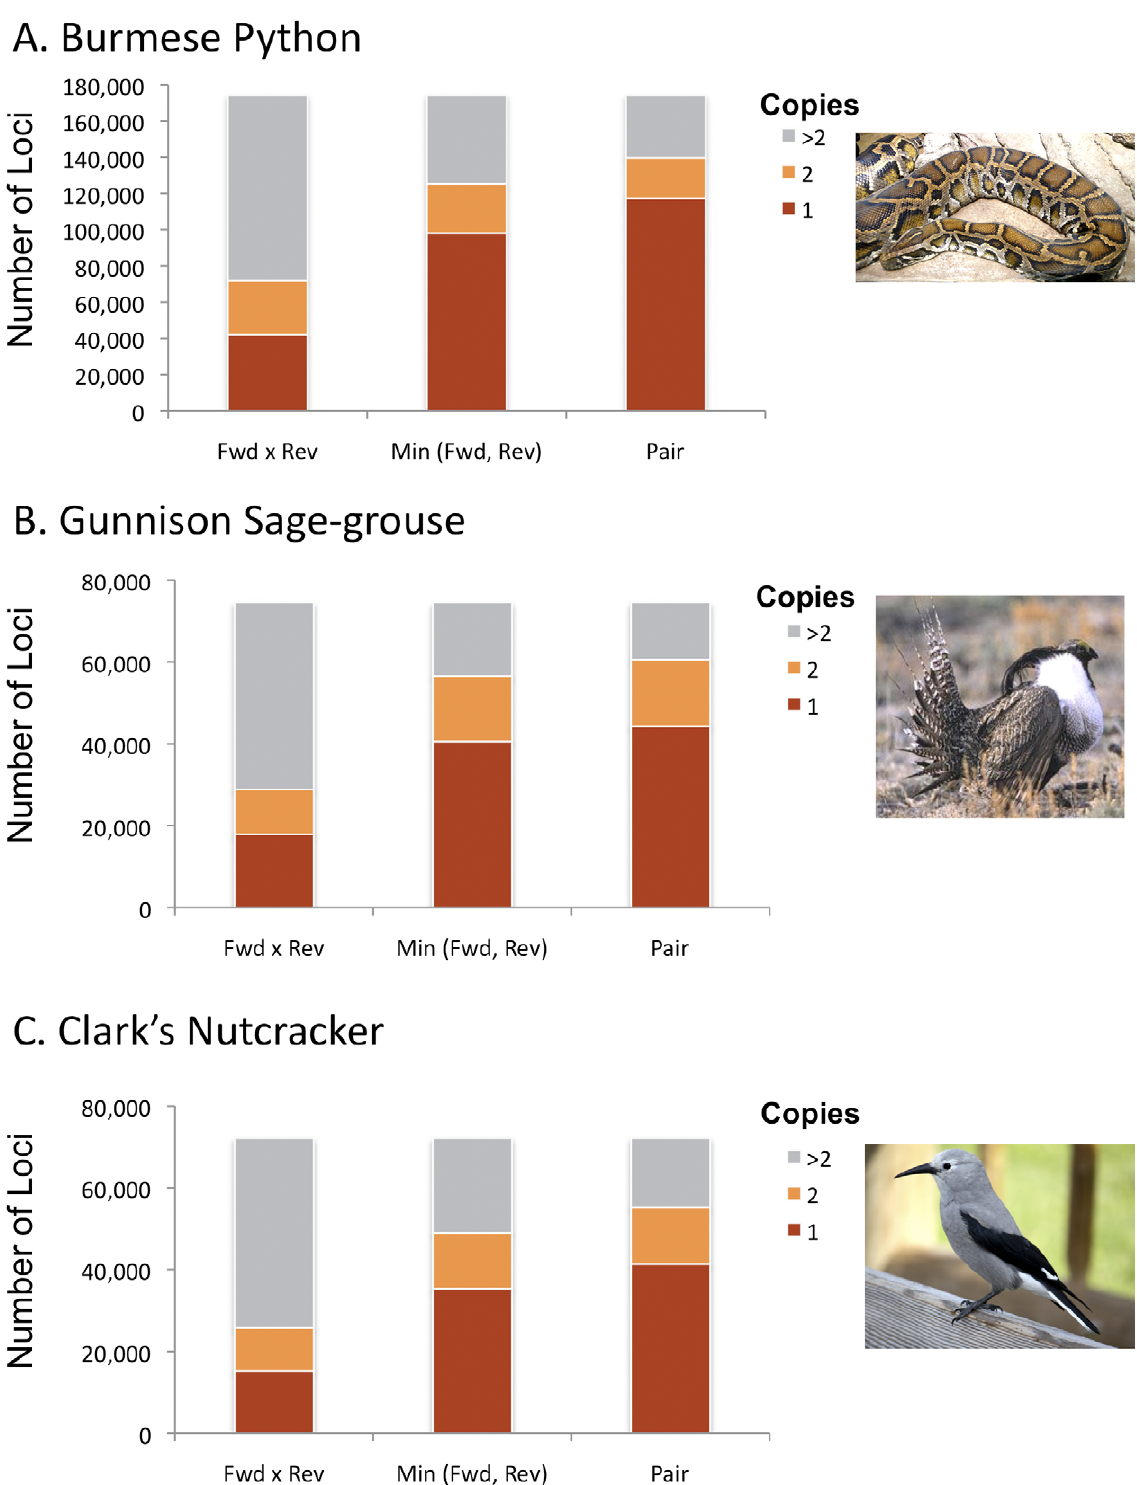
Figure 4. Empirically estimated copy numbers of identified flanking primer sequences for potentially amplifiable microsatellite loci (PALS) for each species. The number of times a primer sequence or primer pair was observed in all data (from five million reads per species) was counted per species to approximate their genomic frequencies. Here the ‘‘Min (Fwd, Rev)’’ represents the minimum copy number of the forward and reverse primers observed in the data. The product of the independent frequencies of the forward and reverse primer sequences (per locus) is also shown (‘‘Fwd 6 Rev Primer’’), as is the frequency that each primer pair was observed together in a set of paired reads (‘‘Primer Pair’’).